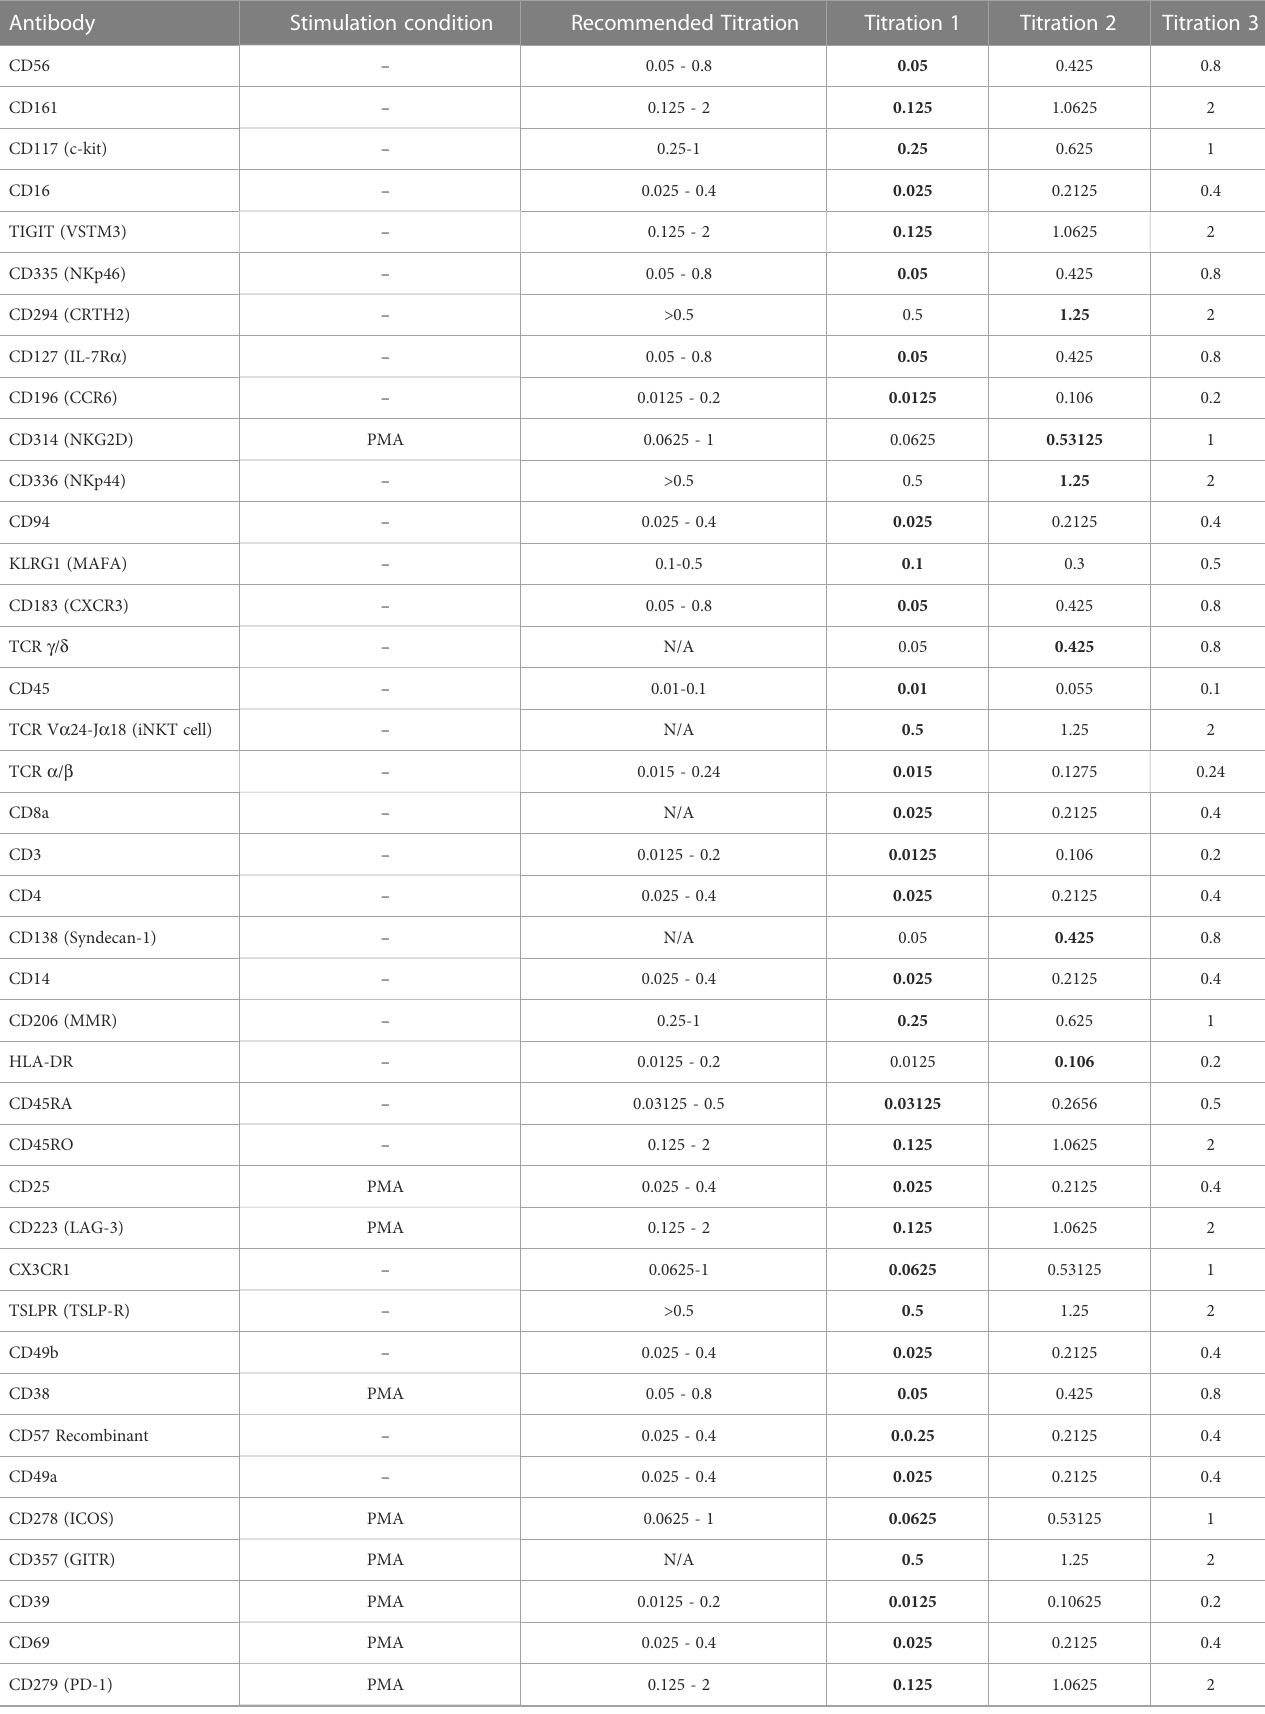
TABLE 3 List of antibodies titrated, stimulation condition, recommended titration from the vendor and 3 point titration